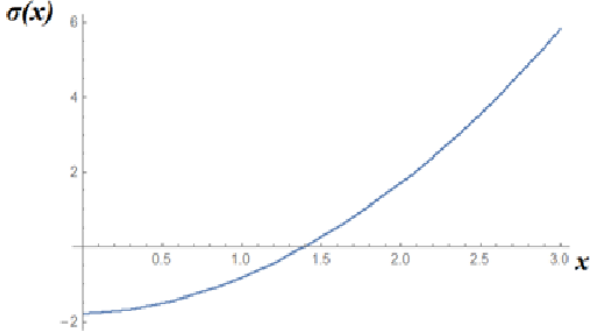
Figure 11: The distribution of stresses in the initial space with re- spect to the initial x axis